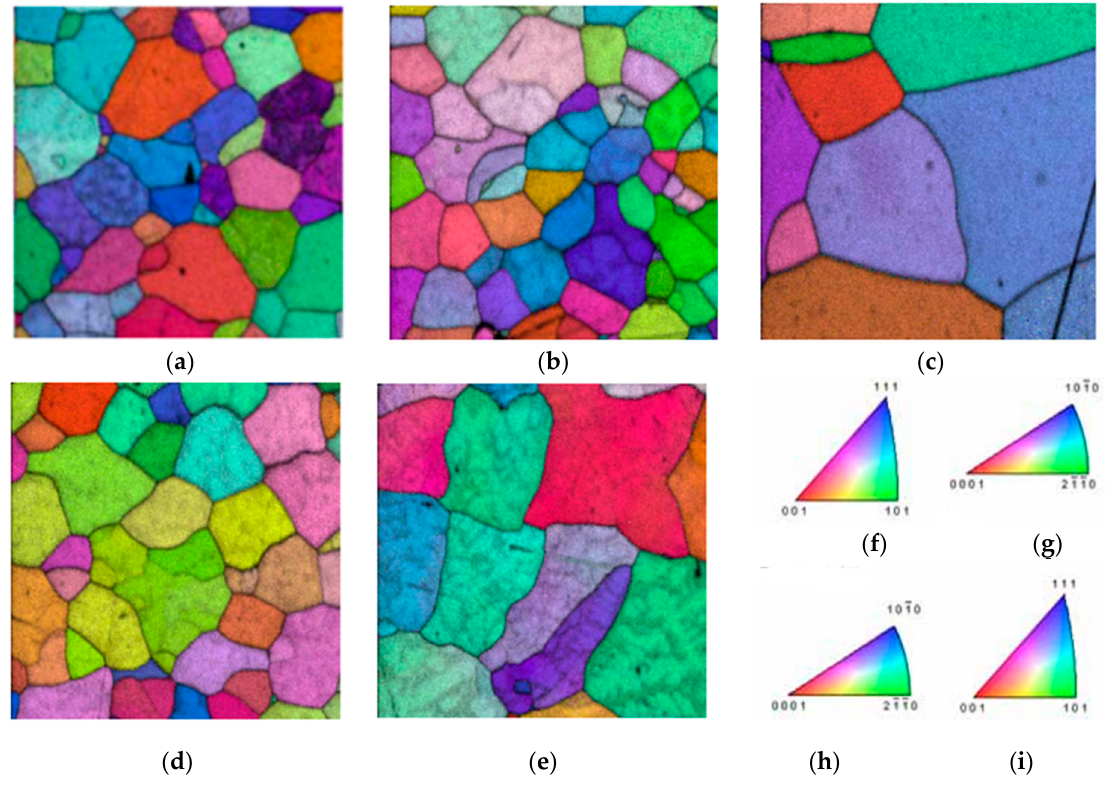
Figure 6. ( a – e ) EBSD inverse pole figure maps for five different samples and pole diagrams for ( f ) Tantalum; ( g ) Zirconium; ( h ) Titanium and ( i ) Niobium.